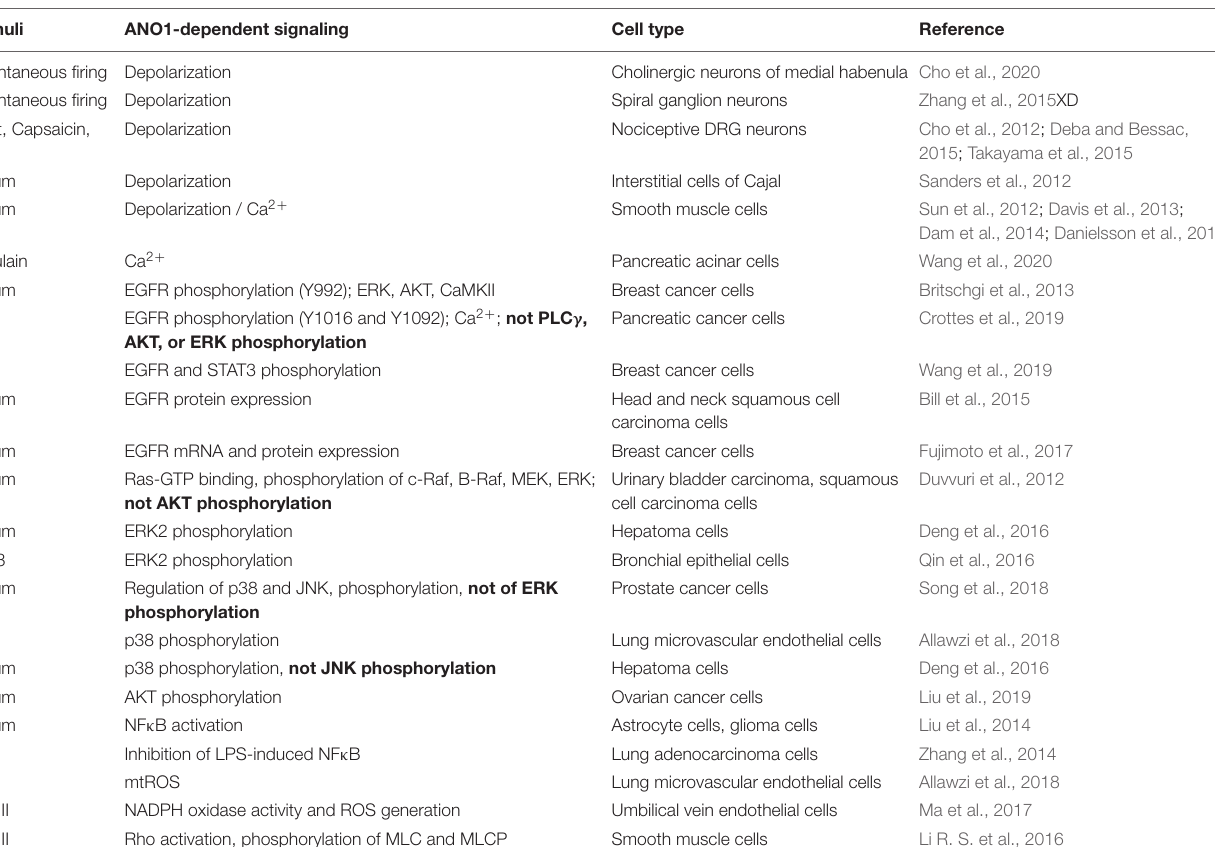
TABLE 2 | Cell signaling mediated by ANO1.